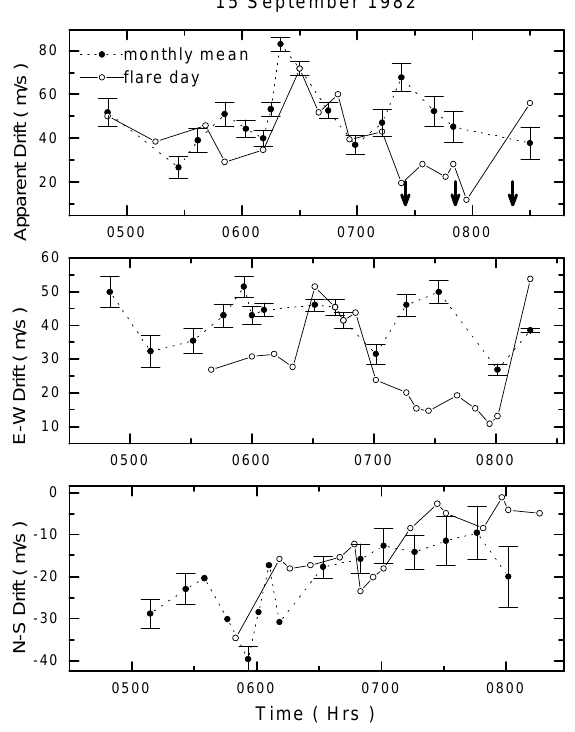
Fig. 6. Variation of Apparent Drift Speed, its E–W and N–S compo- nent during the daytime on 15 September 1982, along with their re- spective monthly mean variation. The solar flare occurred at 07:25, 07:51 and 08:21 (1B). The rest of the details are the same as in Fig.